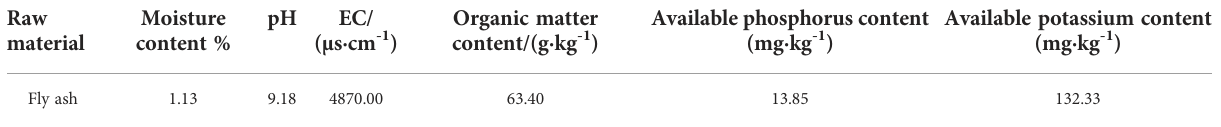
TABLE 4 Basic physicochemical parameters of raw